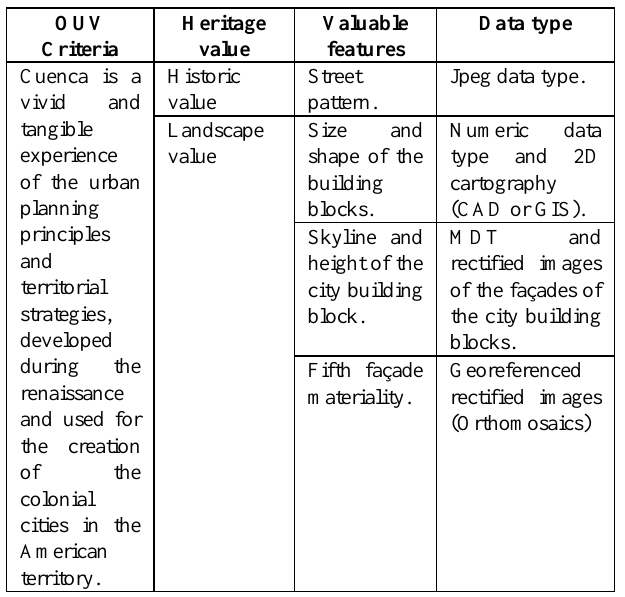
Table 1. Heritage values, valuable features and data types of the historic city of Cuenca.